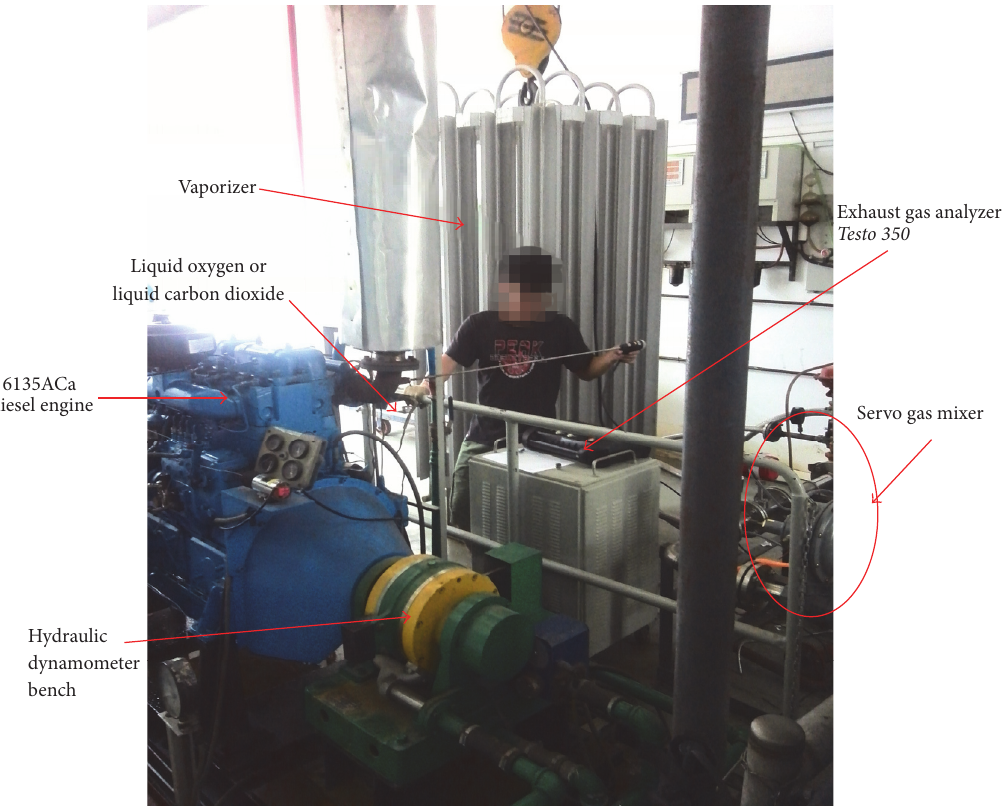
Figure 7: Test plant of the 4135ACa engine.